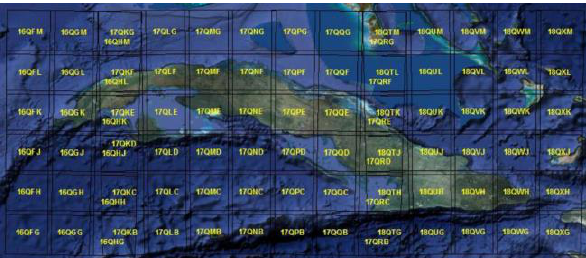
Figure 1. Grid of the SENTINEL 2 corresponding to Cuba and surrounding seas.